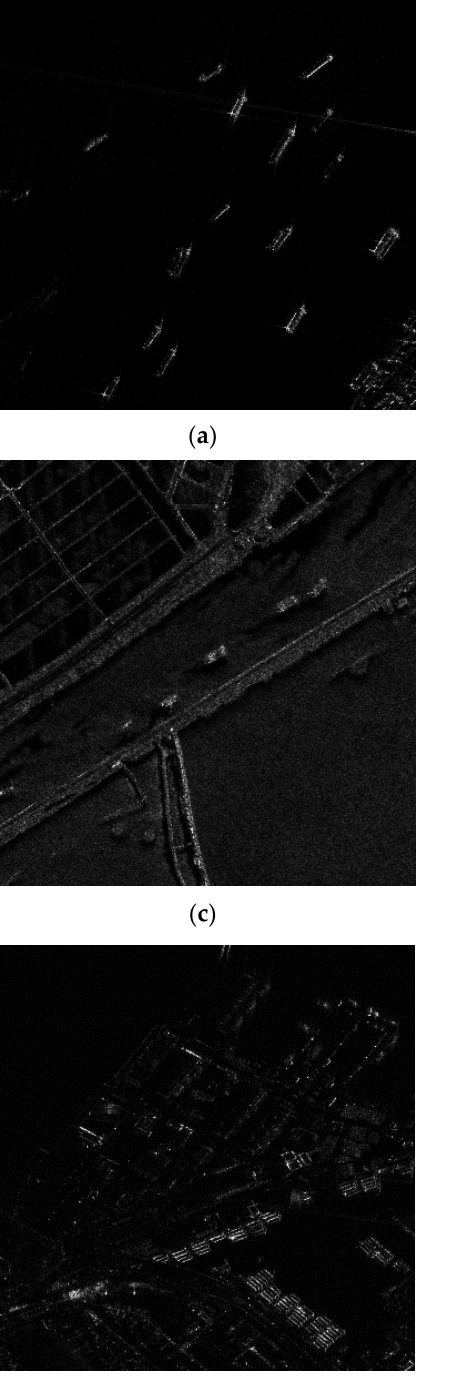
( b ) Figure 4. Comparison of the optical image and the SAR image: ( a ) optical image; ( b ) SAR image. The annotation format refers to the DOTA dataset format [28], and the annotation information of the image is saved in a text file with the same file name. The annotation information of objects can be seen in Figure 5. From the third line to the last line of the text file, a comment for each instance is given, including the coordinates of the four corners of the box, the target category, and whether it is difficult to identify (the default, 0, means it is not difficult). Figure 5. Annotation information of the dataset.